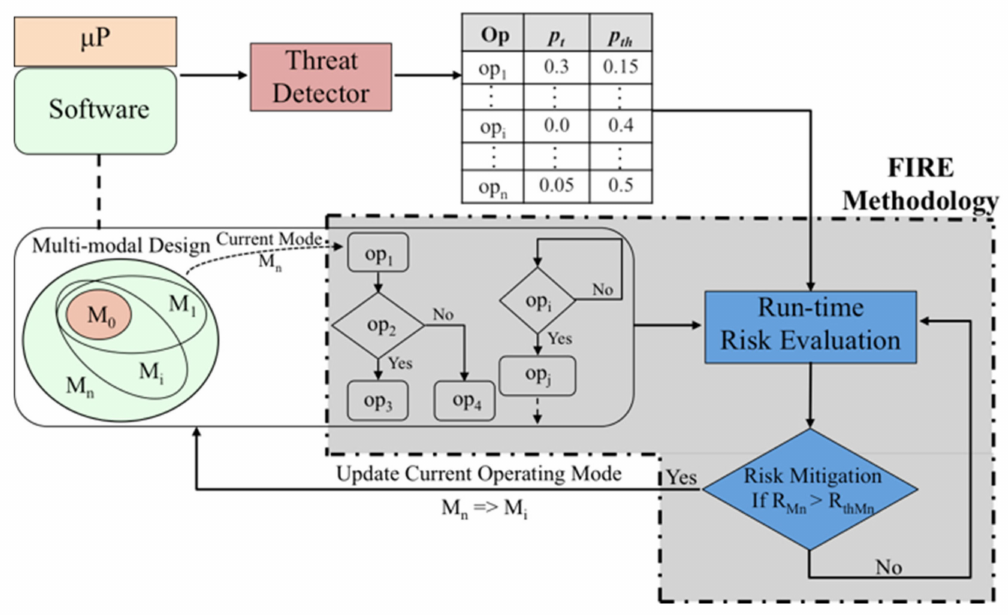
Figure 1. Life-critical embedded system overview: multimodal software design, threat detector f and estimator, and FIRE (runtime risk evaluation and